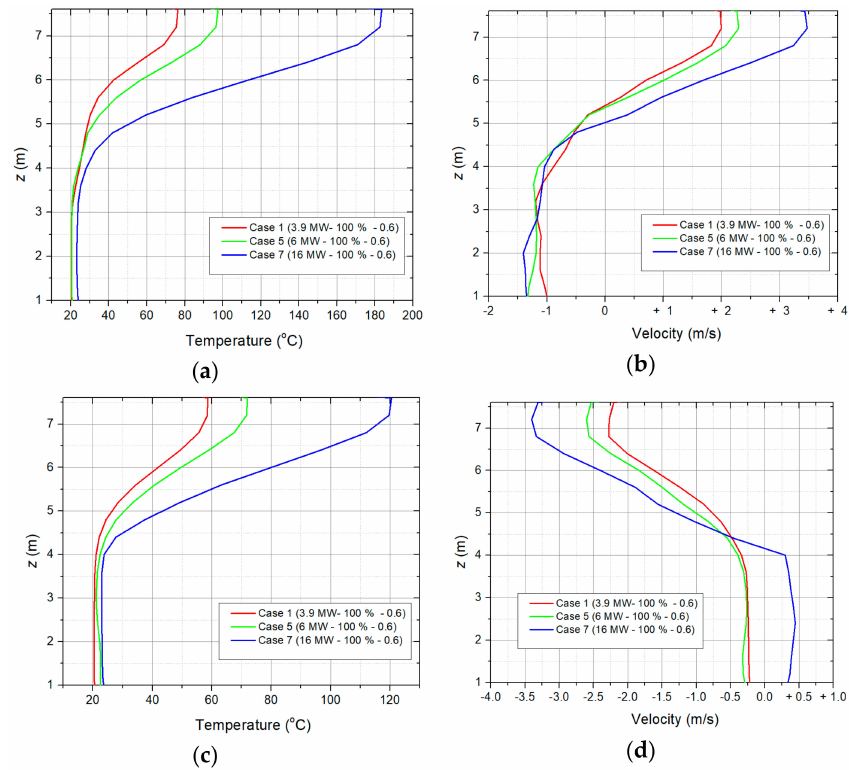
Figure 10. Temperature and velocity distribution in the tunnel: ( a ) temperature distribution at Y = 120; ( b ) velocity distribution at Y = 120; ( c ) temperature distribution at Y = 300 and ( d ) velocity distribution at Y =